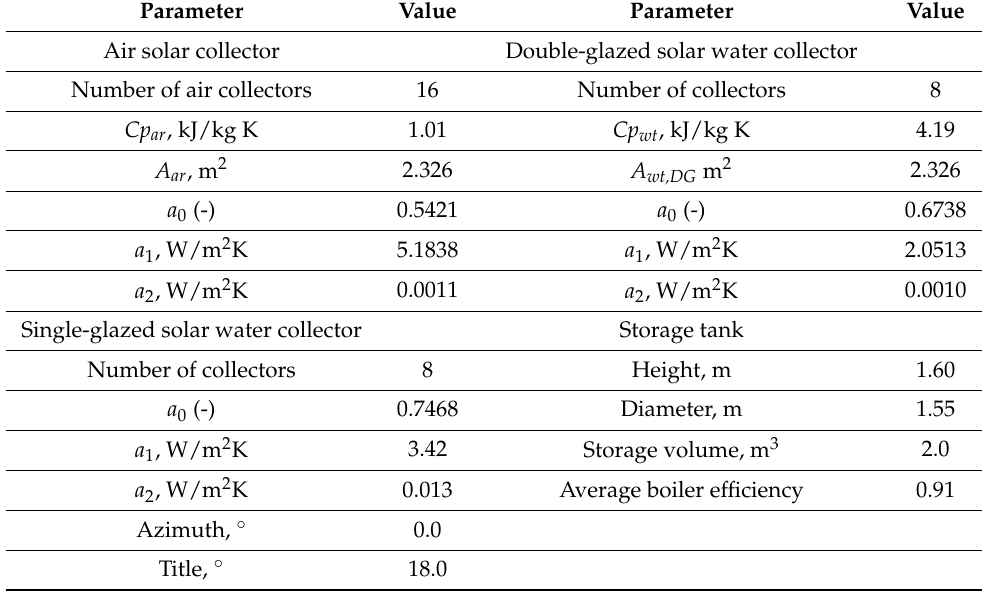
Table 1. Solar heating components